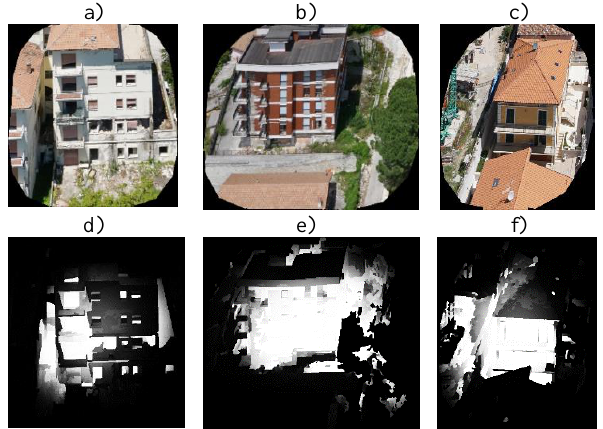
Figure 9 Three examples of the salient object detection results, second row (white regions show a higher probability of the pixel pertaining to the façade) Figure 10 and Figure 11, show the result of the application of the